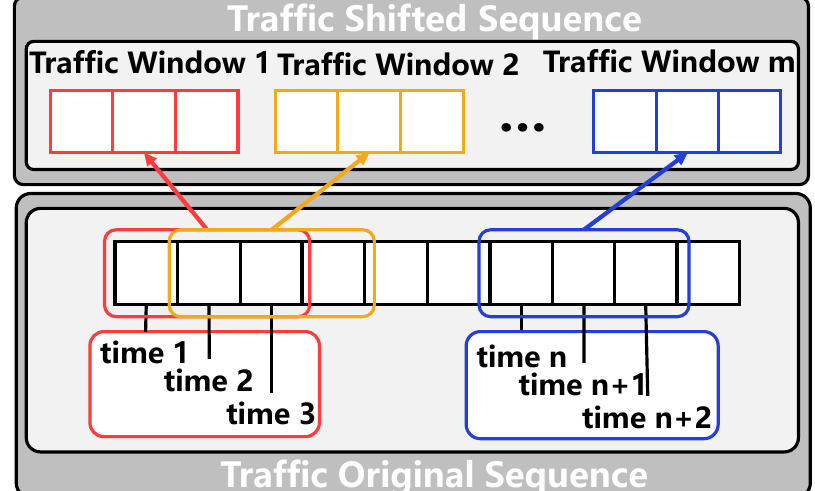
Figure 5. The process of the shifted window